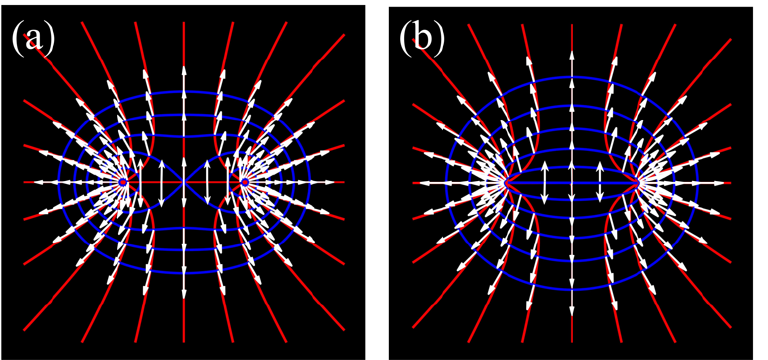
Figure 2. Geometric representation of the polarization distribution of an ESRP beam with respect to various background curves. In ( a ), blue curves represent Cassinian ovals, whereas red curves represent the hyperbolic curves perpendicular to the Cassinian ovals. In ( b ), the blue curves were replaced with confocal ellipses sharing the same foci with the Cassinian